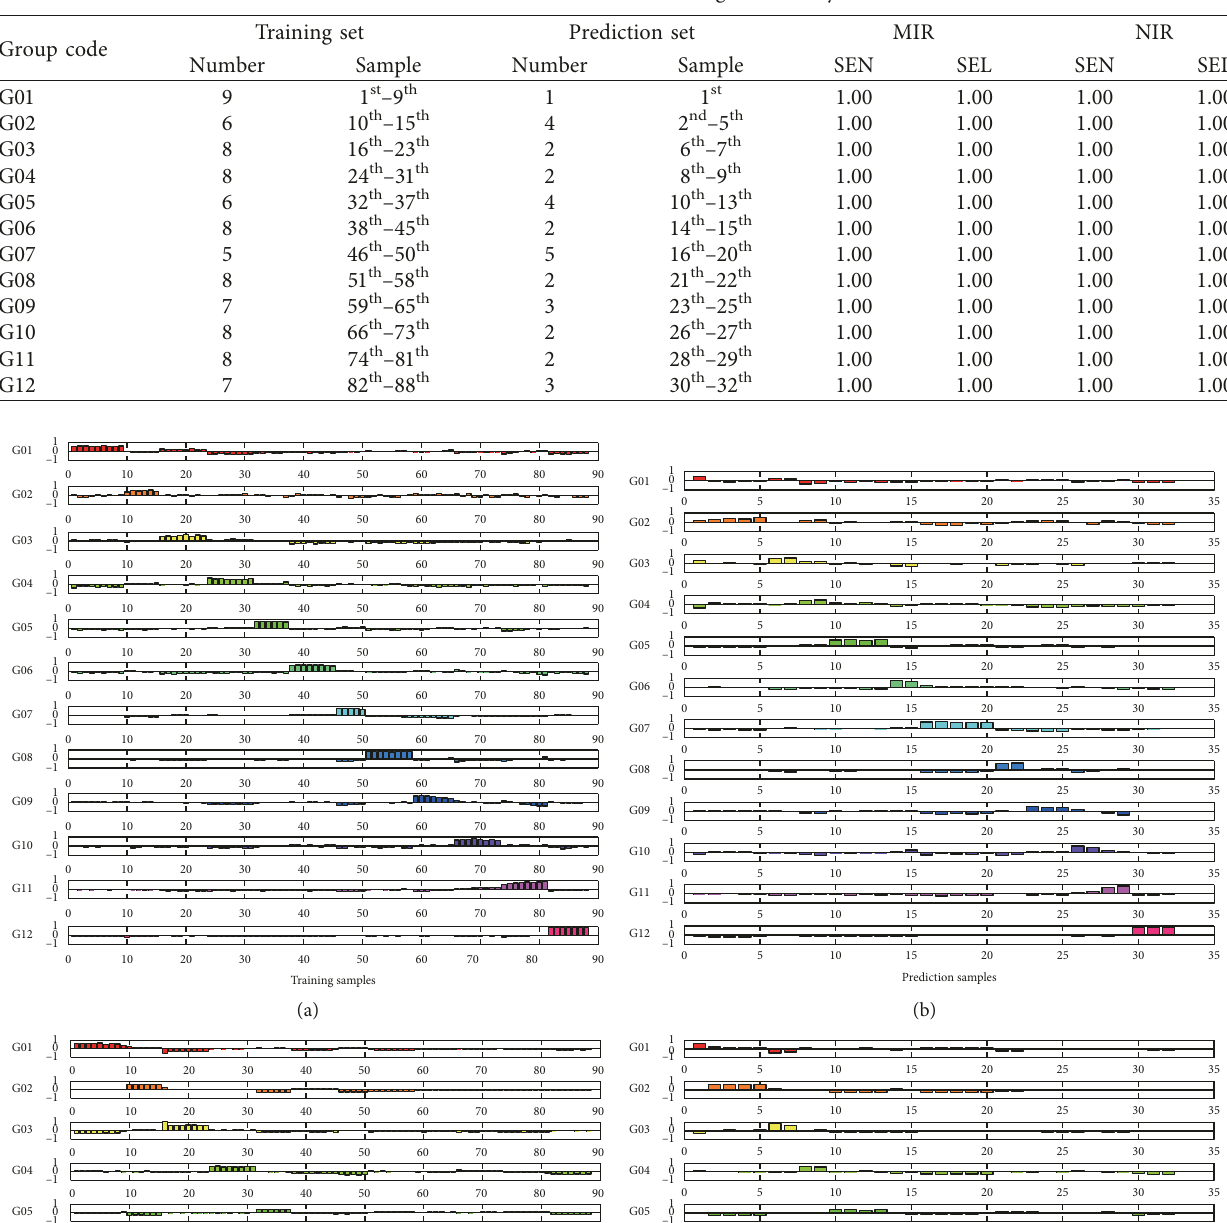
Table 2: FOMs of MIR and NIR models in 12 famous green teas by the PLSDA method.